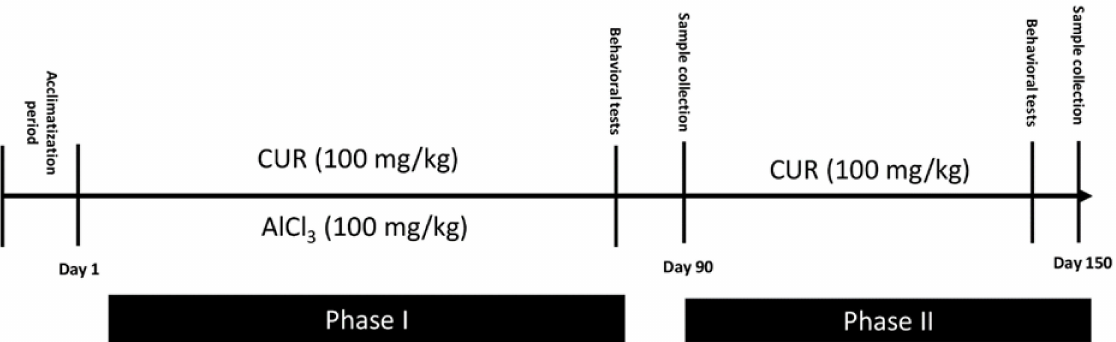
Figure 7. Illustration of the protocol: Timeline showing a summary of the experimental